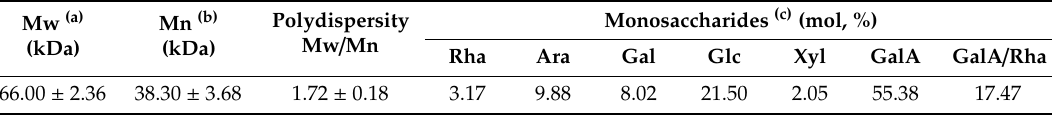
Table 2. Characterization of PWPs extracted from P. major L.